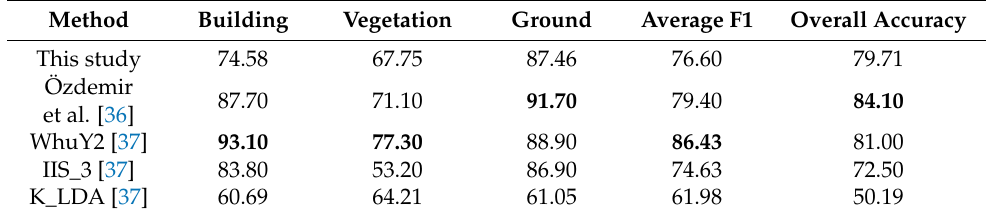
Table 7. Comparison with previous studies for the Vaihingen dataset. F1 score values were compared for each class. All values are given in % (WhuY2, ISS_3, K_LDA results were taken from ISPRS website). The highest-obtained accuracies are shown as bold.